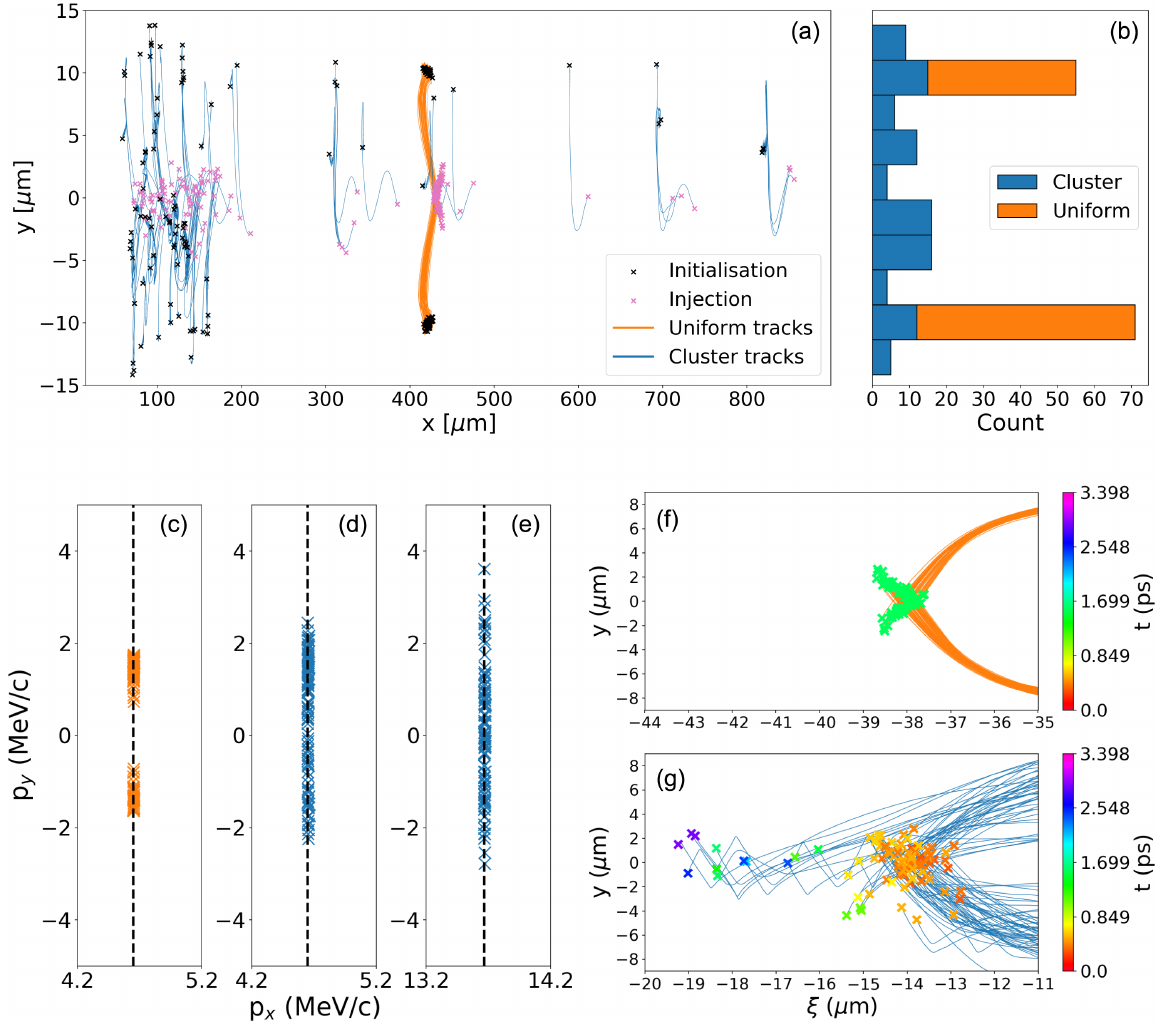
FIG. 6. Analysis of the electron injection behavior. Positions of particle injection and corresponding initialisation (origin) positions for uniform and cluster plasmas (simulations D and G) are shown in panel (a). The histogram in panel (b) presents the abundance of particles born at a certain y-position (initialization at right border of simulation box). The perpendicular momentum at time of injection within the wakefield [threshold calculated using Eq. (1)] is shown for the uniform (c) and cluster (d) case. Panel (e) gives the momentum for a threshold calculated using the higher laser group velocity found in Sec. II D. Plots (f) and (g) show a comparison of injection position in a comoving frame traveling at the speed of light for the uniform and cluster case. The color of the “ x ” -markers corresponds to the time at